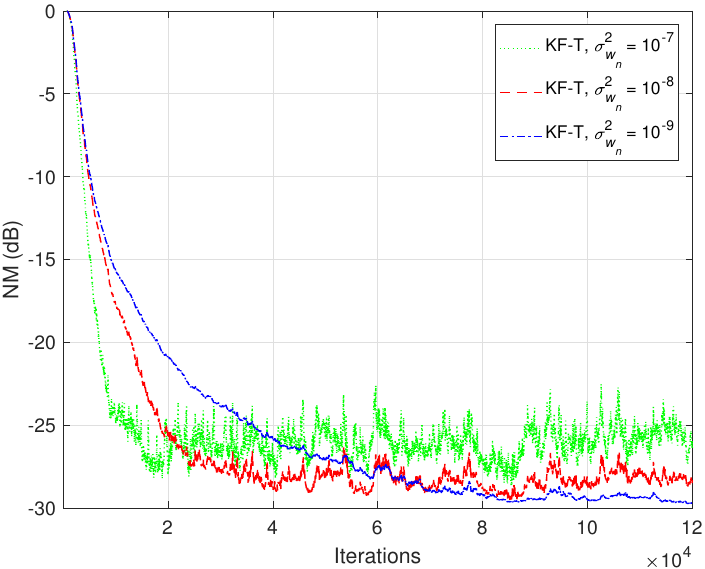
Figure 15. Normalized misalignment (NM) of the KF-T using different values of σ 2 w for the identification of the global impulse response, h ( t ) + u ( t ) , where u ( t ) is randomly generated (Gaussian distribution), with variance υ (cid:107) h ( t ) (cid:107) 2 / L , using υ = 10 − 3 . The input signals are speech